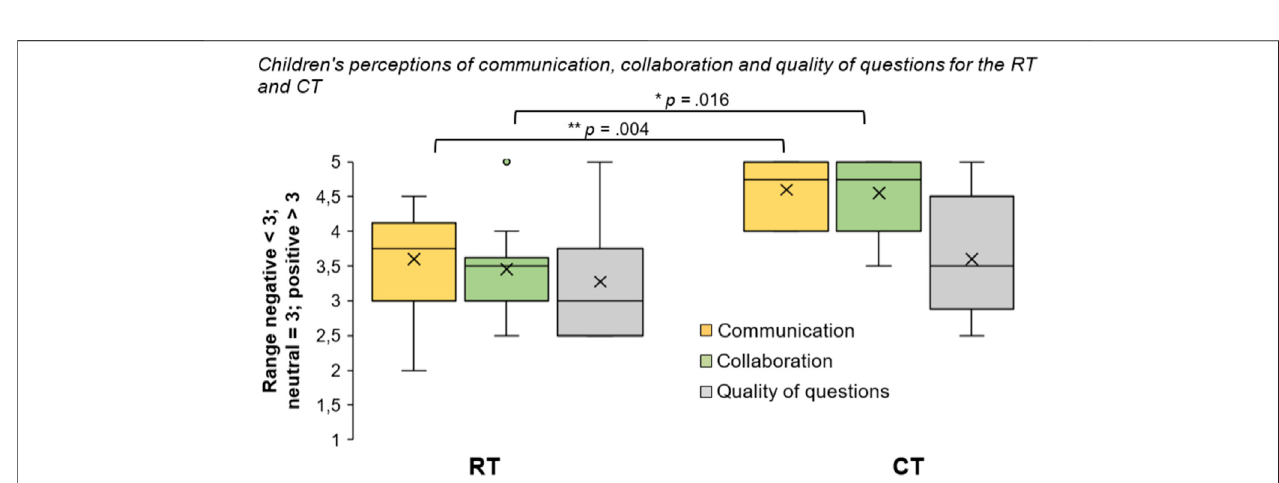
FIGURE 3 | Box plots showing children ’ s perceptions of ease of communication, collaboration and quality of questions for the RT and CT (x = means; lines = medians; whiskers = ranges). * p < 0.05. ** p < 0.01.